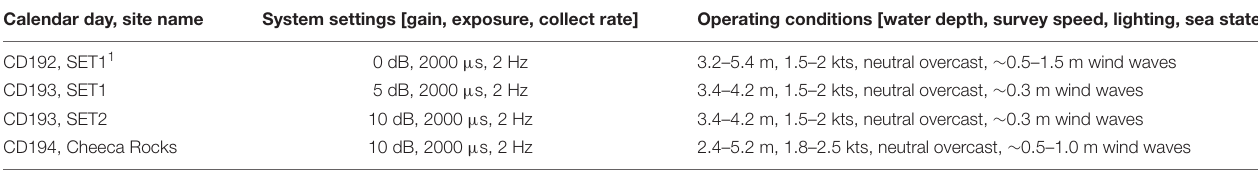
TABLE 2 | Environmental conditions and system settings used at each survey site.